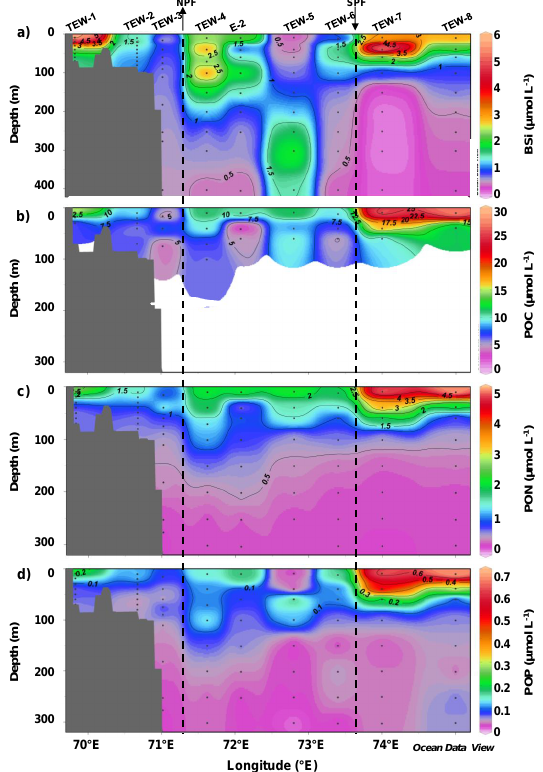
Figure 9. Figure 9. Vertical distributions of BSi (a) , POC (b) , PON (c) , POP (d) concentrations along the TNS transect. The dashed line repre- sents the approximate location of the southern branch of the polar front (PF).